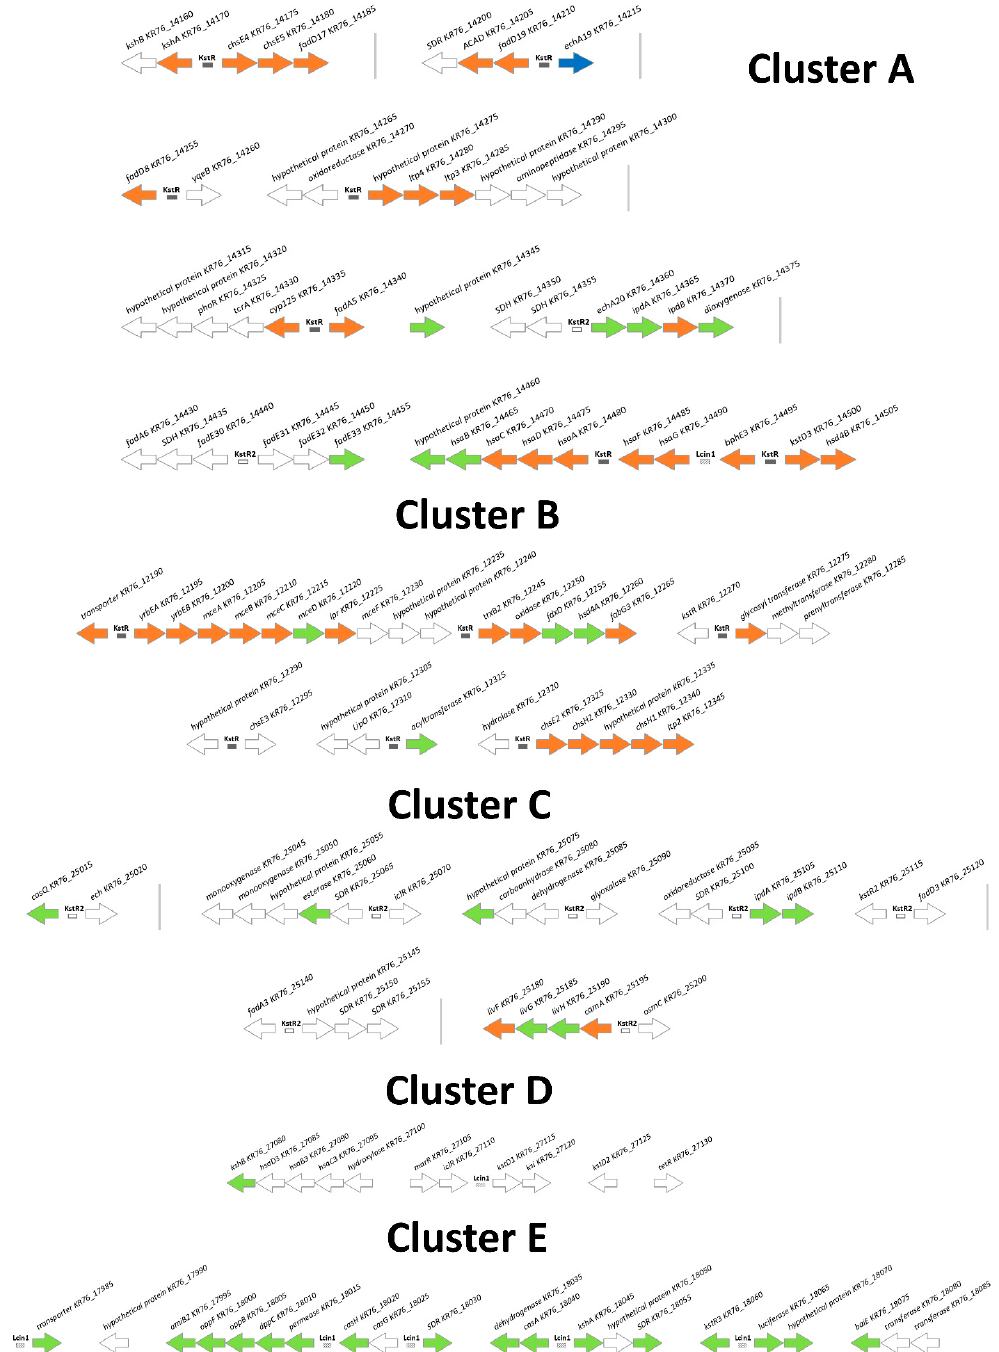
Figure 3. Clusters of N. simplex VKM Ac-2033D genes coding for steroid metabolism related proteins. Genes are ordered from top left to bottom right. Vertical lines designate regions where several genes are omitted. Neighboring operons are separated by a larger space. Filled rectangles denote predicted KstR binding sites, empty rectangles denote predicted binding sites of KstR2, rectangles with diagonal shading—predicted Lcin1 binding sites. White arrows indicated genes with no observed expression increase, blue arrows—genes with expression increased on medium with cholesterol, green arrows—genes with expression increased on medium with LCA, orange arrows—genes with expression increased on both